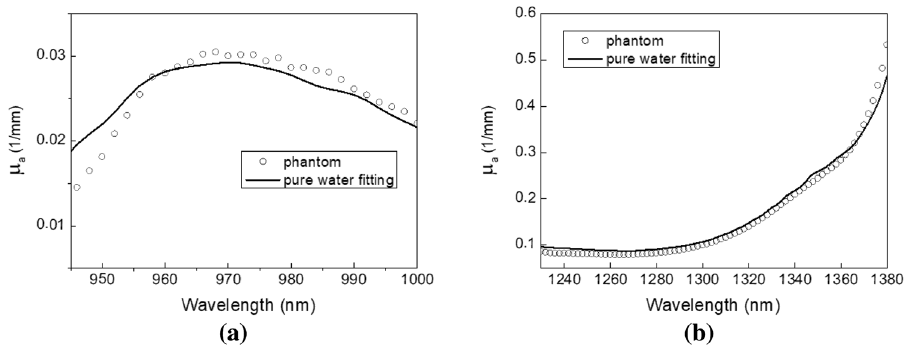
Figure 1. Absorption spectra of the bound water phantom at the first and second water absorption overtone bands. Measured absorption spectra (dotted lines) and the best pure water absorption spectrum fit to them (solid lines) at ( a ) 945–1000 nm, and ( b ) 1230–1380 nm are